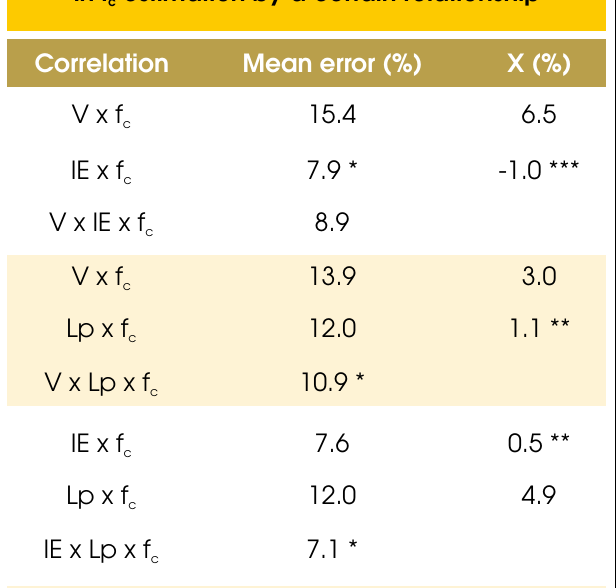
Table 7 – Summary of the analysis of errors in f estimation by a certain relationship c